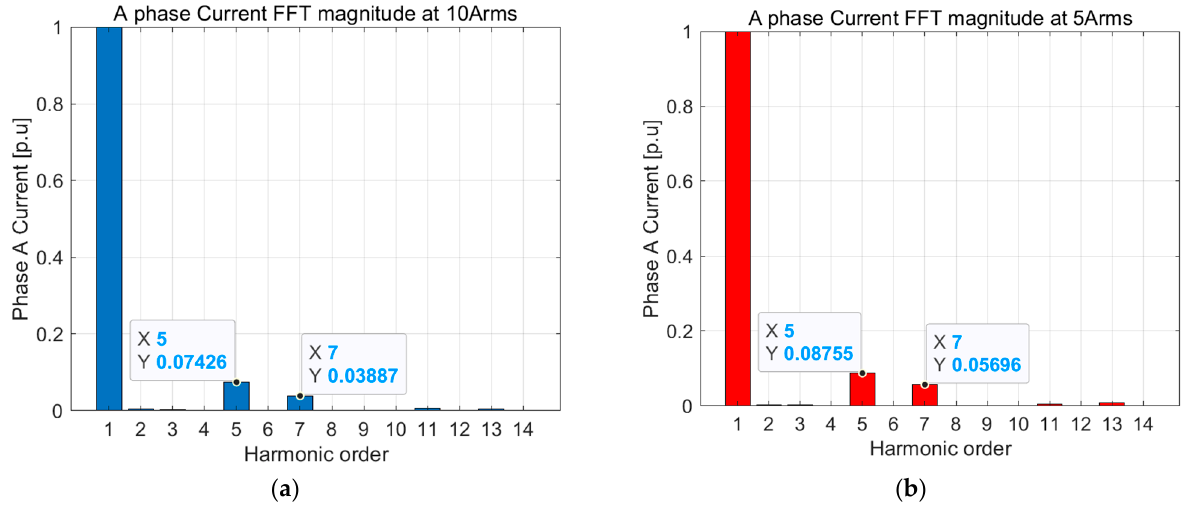
Figure 18. A-phase current FFT magnitude plot at ( a ) 10 and ( b ) 5 Arms.